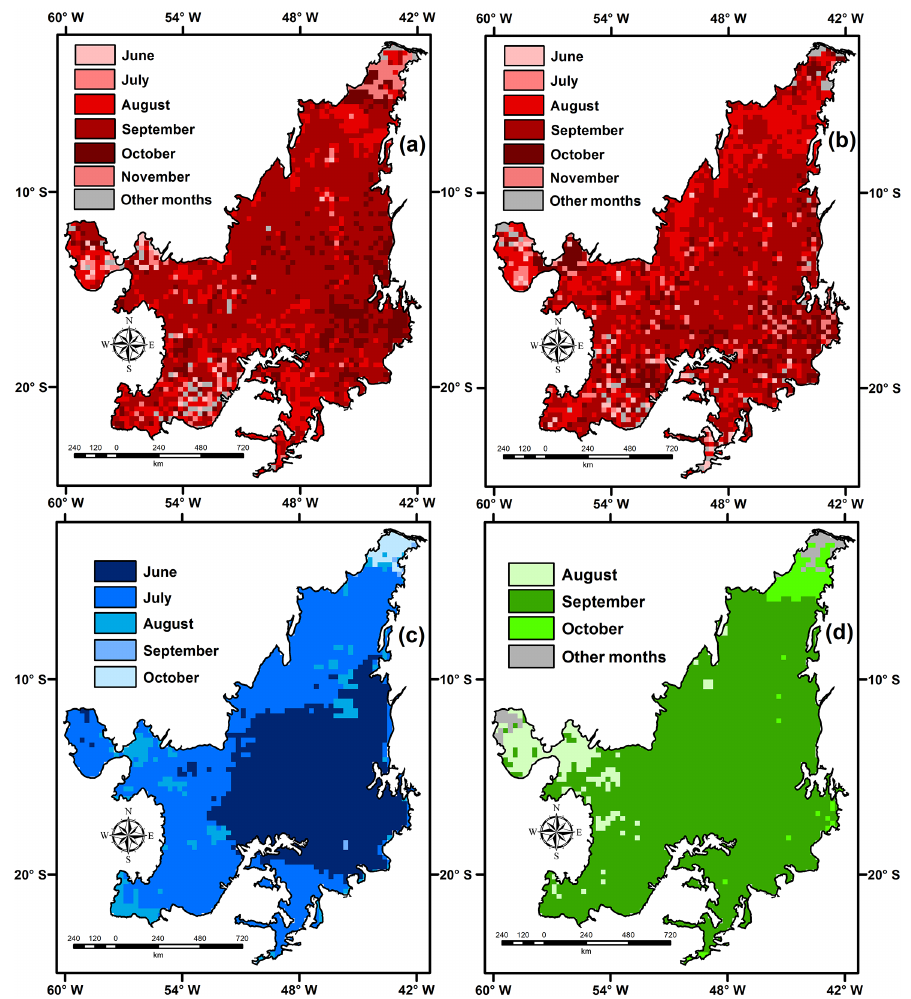
Figure 4. Estimate of the month when (a) maximum of hotspots, (b) maximum of burned area, (c) minimum of precipitation and (d) minimum of VCI were found in the Cerrado for the 2002–2015 time